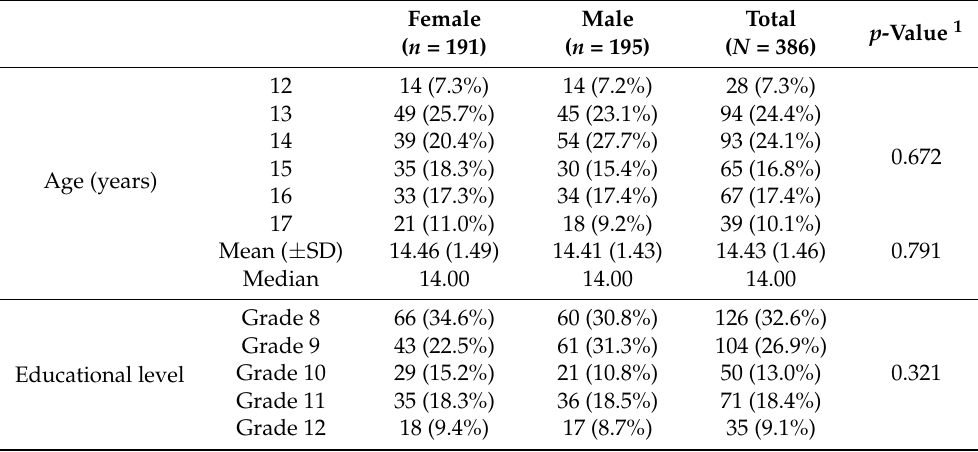
Table 1. Sample characterization: age and educational level of the participants by sex.